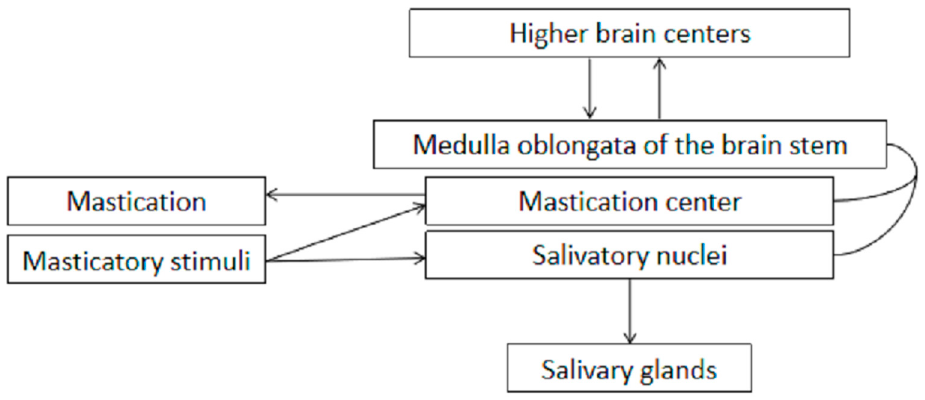
Figure 2. Schematic diagram explaining how mastication influences salivary secretion.